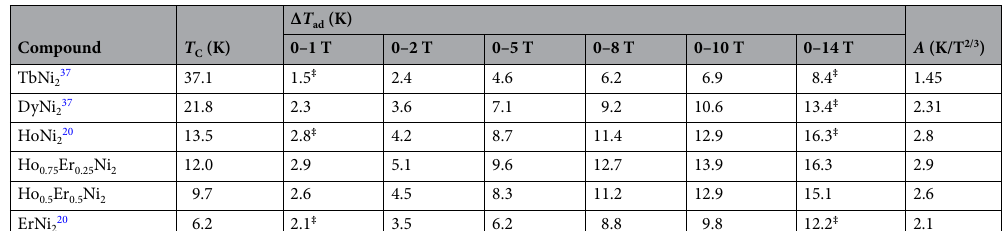
Table 3. Experimental data characterizing the adiabatic temperature change, Δ T ad , due to MCE caused by the magnetic field change, µ 0 Δ H , for the selected binary RNi 2 intermetallic compounds and for Ho 0.75 Er 0.25 Ni 2 and Ho 0.5 Er 0.5 Ni 2 solid solutions. A is the coefficient from equation Δ T ad = A (µ 0 Δ H ) 2/3 . The data were obtained by direct measurements of Δ T ad during the field change, µ 0 Δ H , achieved by using the extraction method in a Bitter magnet. The values of Δ T ad marked with ‡ symbol are estimated by the extrapolation of the Δ T ad = A (µ 0 Δ H ) 2/3 relation. The characteristic temperatures were calculated to an accuracy of ± 0.1